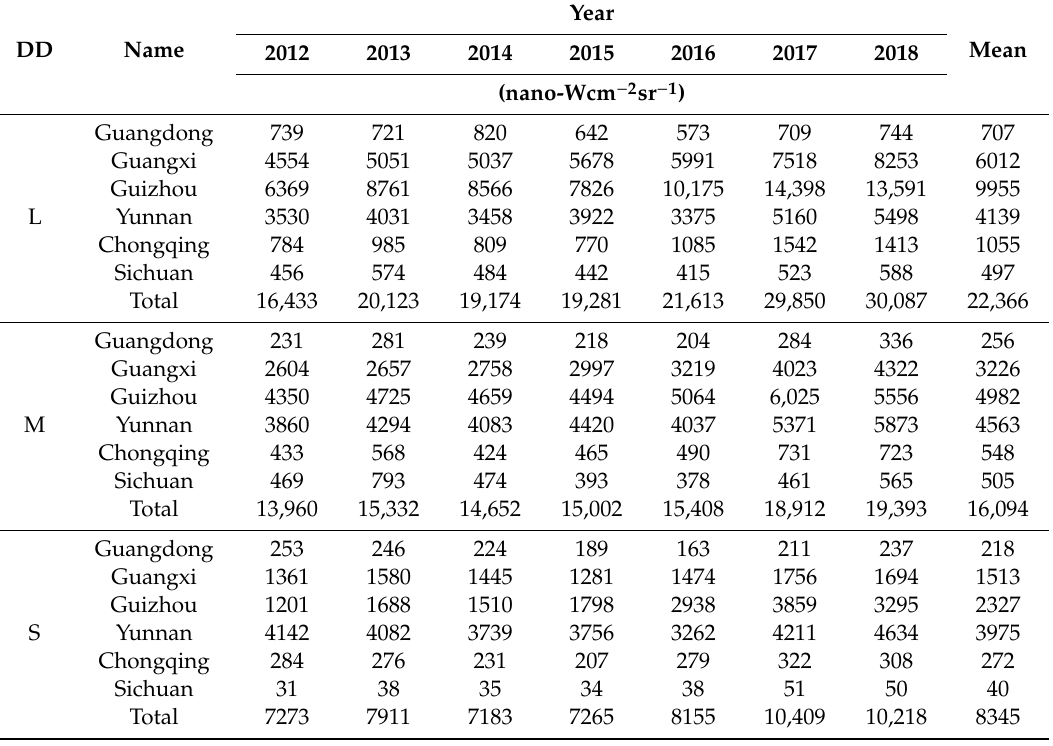
Table 1. The total nighttime lights related to karst rocky desertification in southern